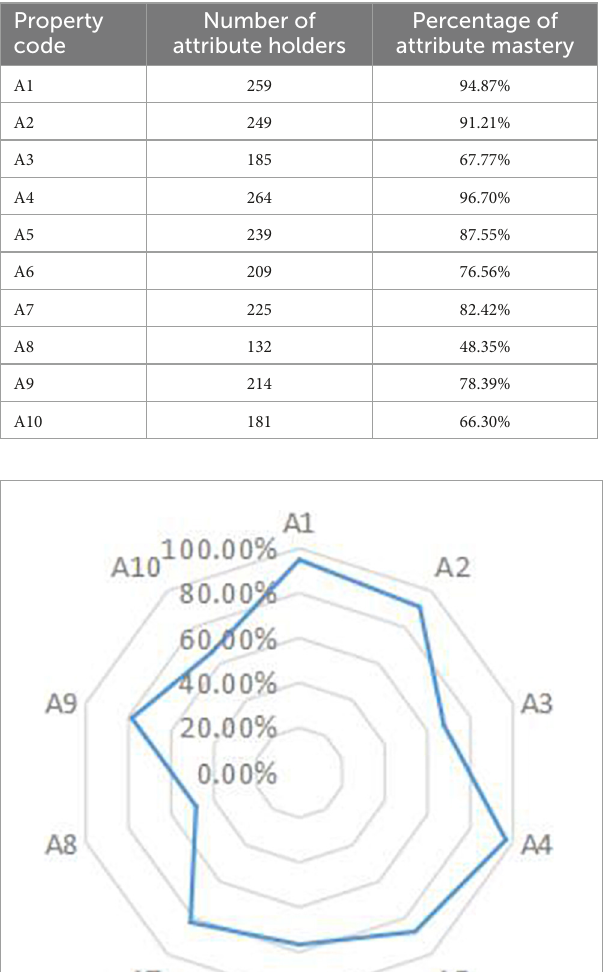
TABLE 7 Cognitive attribute mastery statistics.